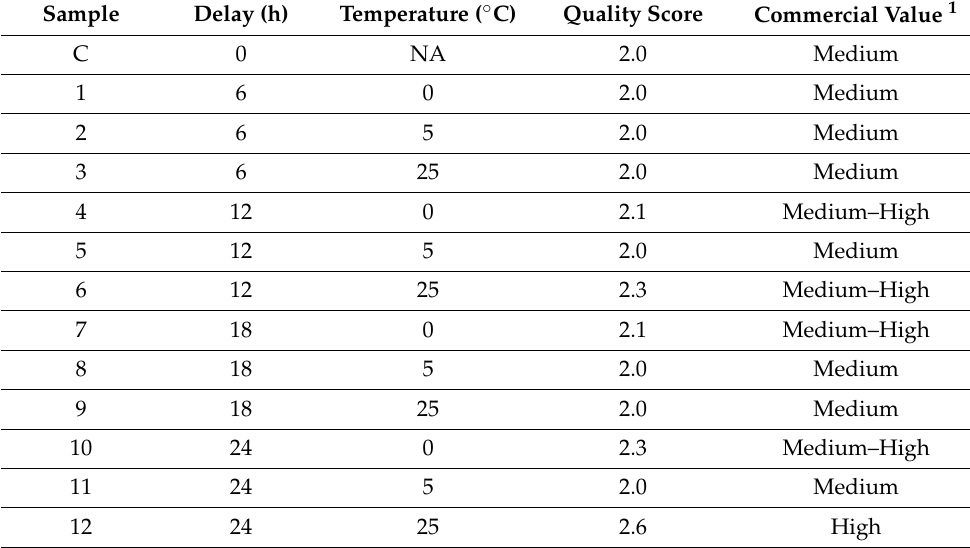
Table 2. Effect of post-harvest processing delay and variation in storage temperature on green tea quality score and commercial